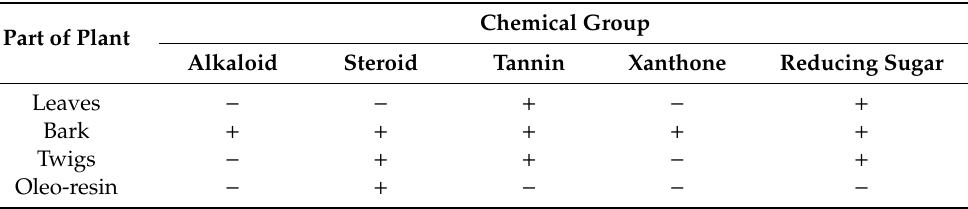
Table 1. Phytochemical screening of D. alatus